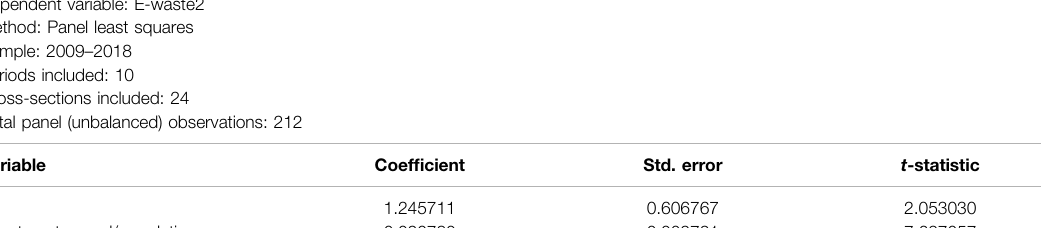
TABLE 5 | Parameters of the fi xed effect (FE) model (FEM) / Source: Own calculation using EViews 11. Dependent variable: E-waste2 Method: Panel least squares Sample: 2009 – 2018 Periods included: 10